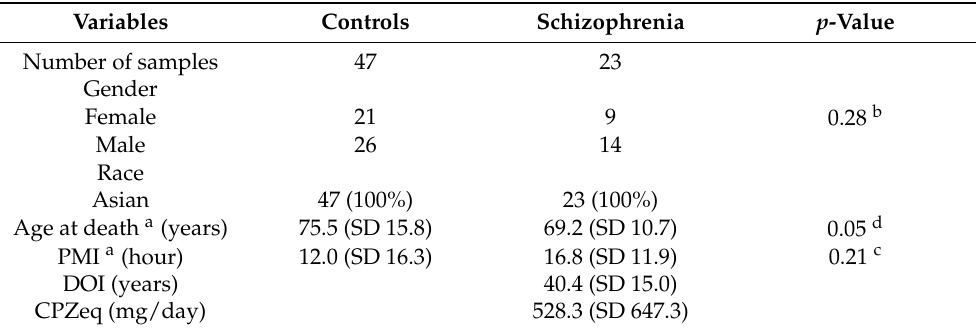
Table 2. Demographic information and clinical characteristics of patients with schizophrenia and matched